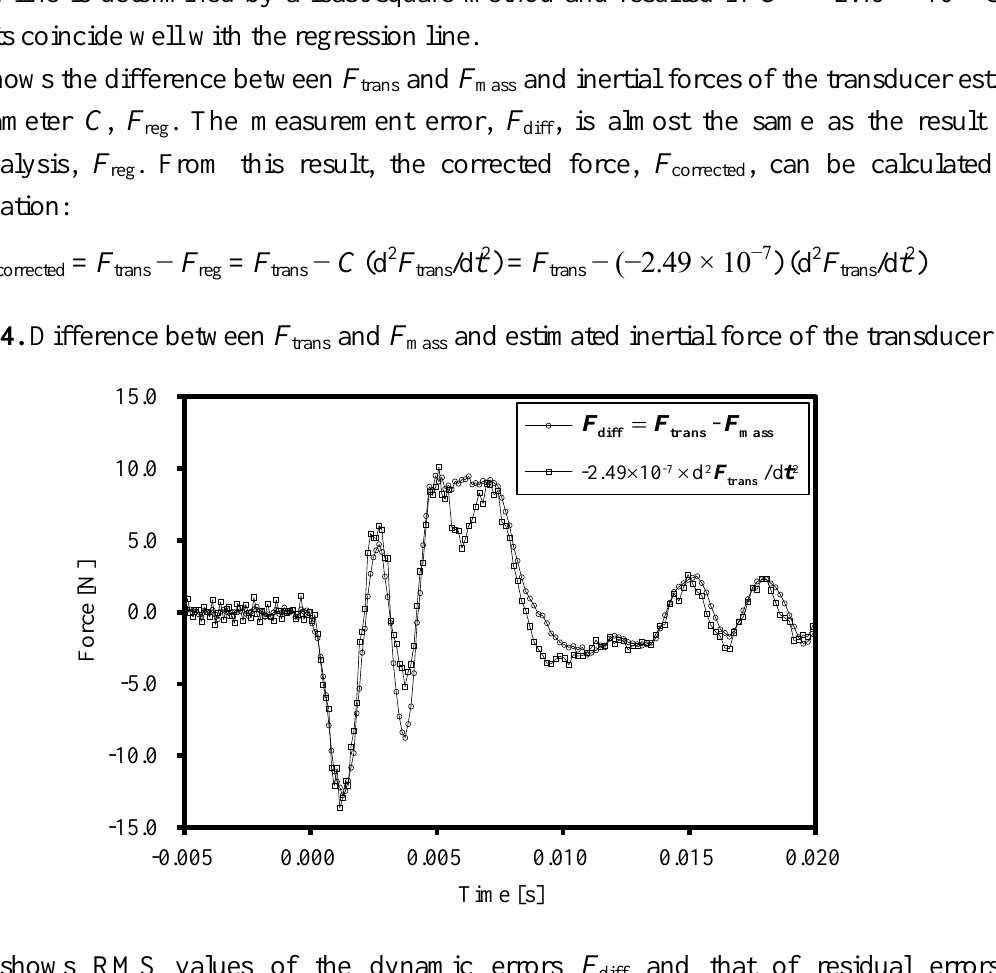
Figure 4. Difference between F